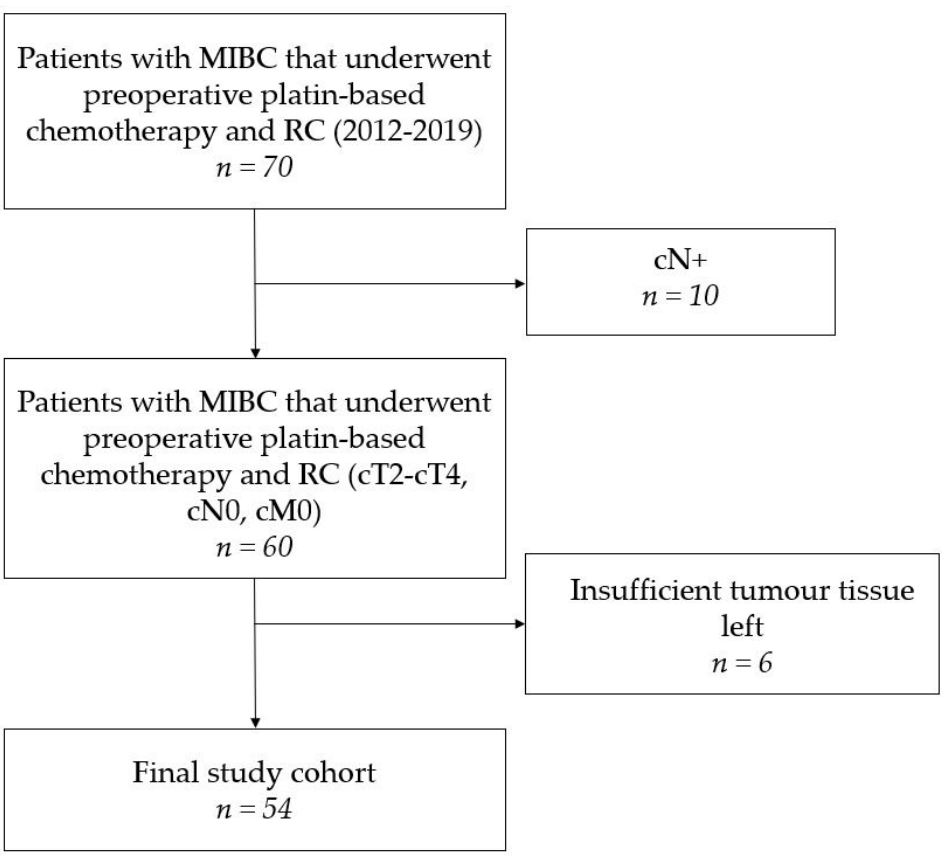
Figure 1. Flowchart of the study cohort. (MIBC: muscle-invasive bladder cancer, NAC: neoadjuvant chemotherapy, RC: radical cystectomy) .